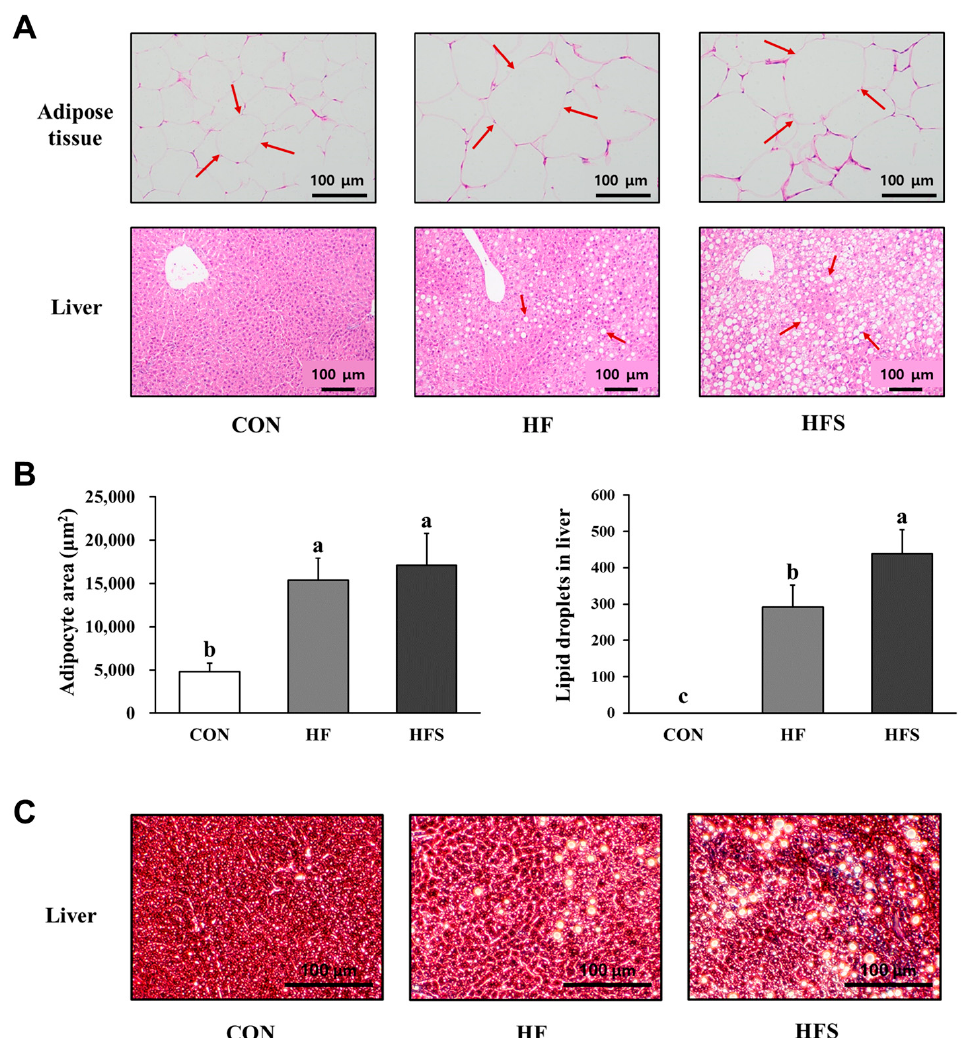
Figure 1. Representative images of lipid droplets observations using hematoxylin-eosin in the epididymal white adipose tissue and liver ( A ), adipocytes area in the epididymal white adipose tissue, lipid droplets in the liver ( B ), and representative images of Sirius red staining in the liver ( C ) from mice. C57BL/6J mice were fed an AIN-93G (CON), high-fat diet (HF; AIN-93G with 60 kcal% fat), or high-fat diet with 10% sucrose water (HFS) diet for 12 weeks. All data are expressed as the mean ± standard deviation. Different letters (a > b > c) indicate a significant difference among treatments. Multiple comparisons of means were performed using Duncan’s multiple range test at the 0.05 significance level ( n = 8).